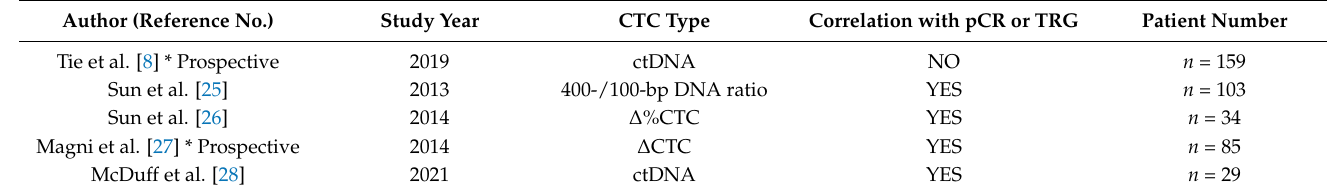
Table 1. Human studies of circulating tumor cells characteristics regarding tumor response after neoadjuvant treatment for locally advanced rectal